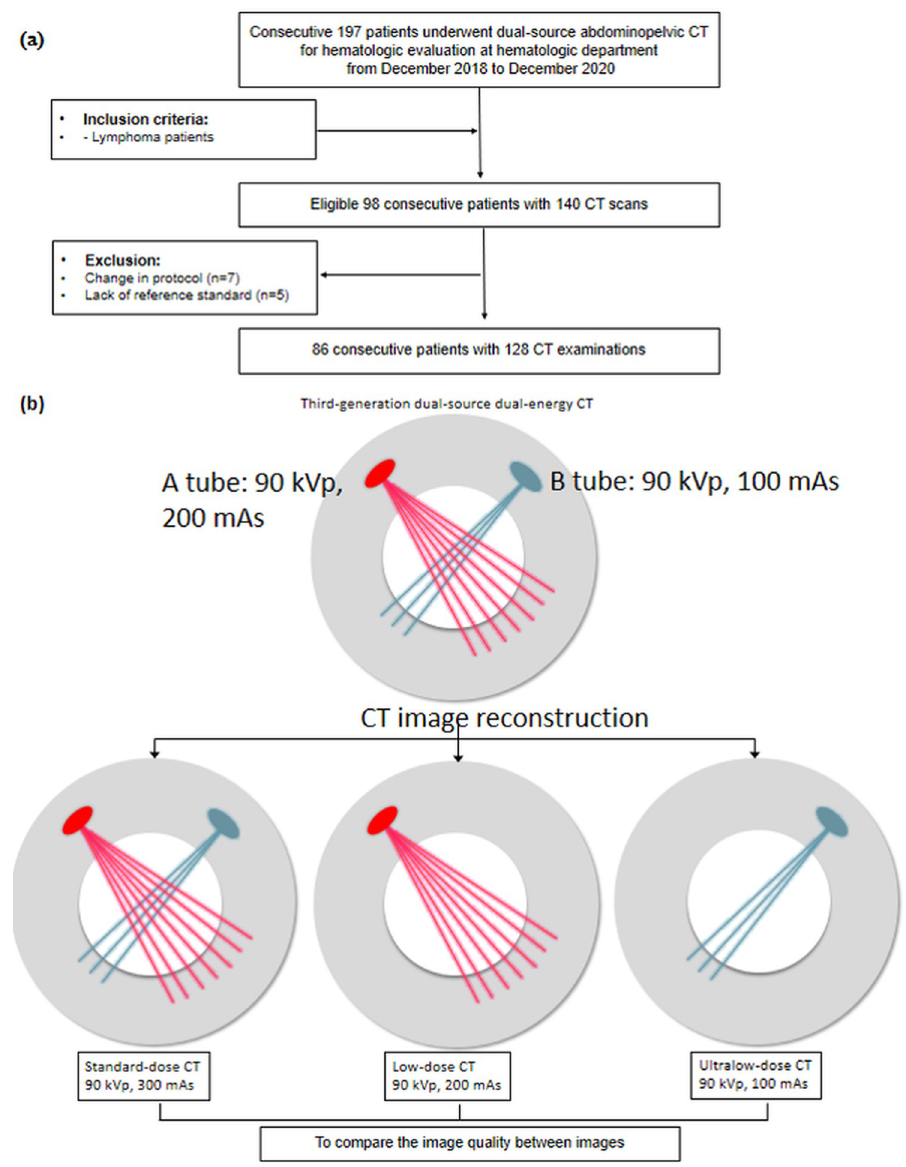
Fig 1. Flow diagram of patients. (a) Inclusion flow chart and (b) computed tomography (CT) examinations and reconstruction methods. aorta lumen in L1 vertebral body level with same location in three image sets. The standard devia- tions (SDs) in Hounsfield units (HU) were measured by a 1–3 cm 2 ROI by a single-blinded reader (S.J.Y.), as image noise. Mean attenuation values (HU) were measured for each ROI. Radiation dose The volume CT dose index (CTDI ) and dose-length product were documented in the dose vol page of the scanner. In the calculation of effective dose, tissue-weighting factors for the abdo- men was used in millisieverts (mSv) (male, k = 0.013; female, k = 0.017) and pelvis (male, k = 0.010; female, k = 0.016) using average values (male, k = 0.012; female, k = 0.017) [21, 22].